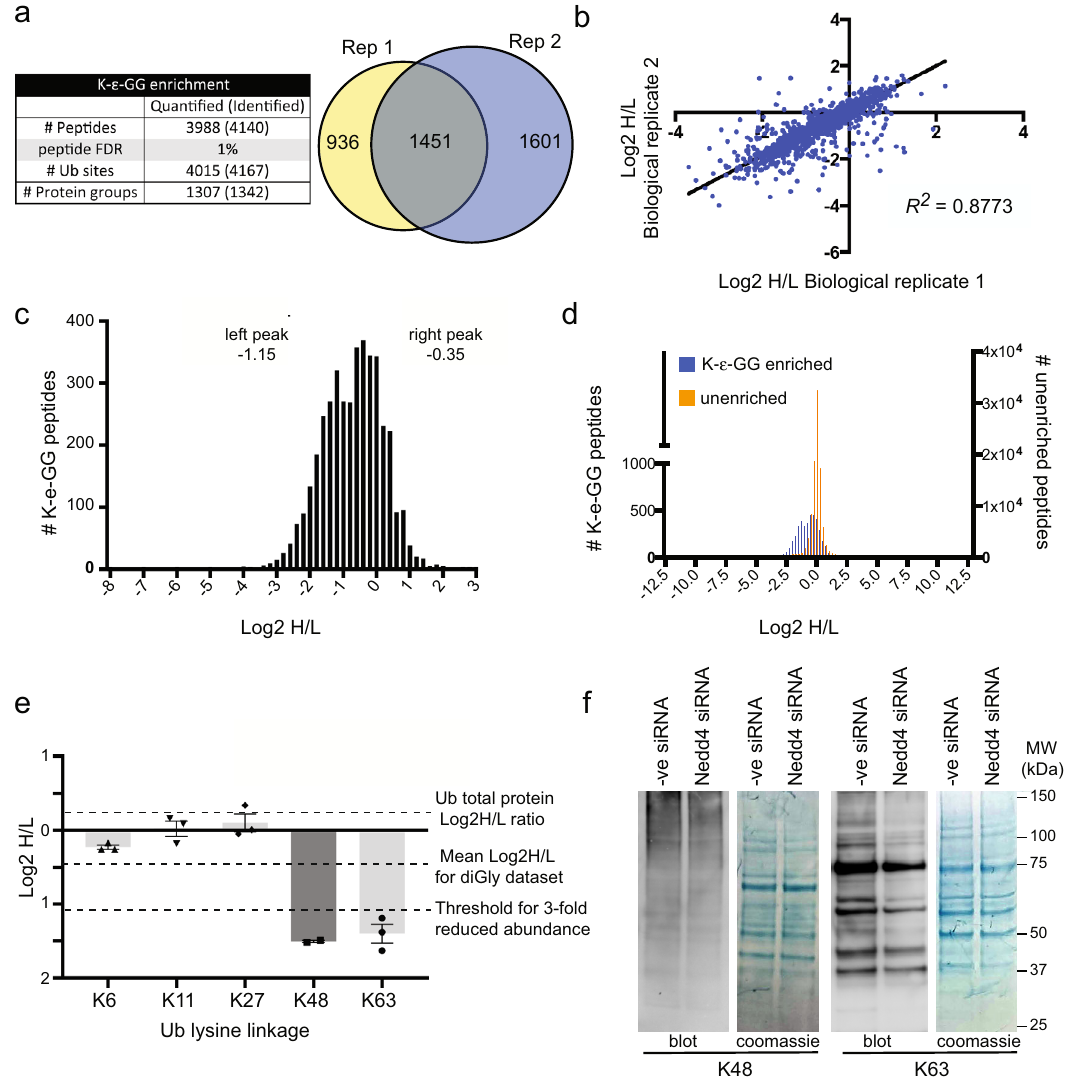
Fig. 2 Quantitative proteomic pro fi ling of NEDD4 regulated ubiquitination events. a Number of quanti fi ed ubiquitin (ub) remnant peptides and cognate protein groups (total number observed given in brackets). Venn diagram shows overlap of ubiquitin remnant peptides across 2 biological replicates (Rep). b Correlation of log2 H/L ratios between replicates ( R 2 = 0.8773). c The frequency distribution of log2 H/L ratios for ubiquitin remnant enriched (K- ε -GG) peptides has a large subset of ubiquitin remnant enriched peptides shifted left. The left peak has a mean of − 1.15 and right peak − 0.35. d Overlay of log2 H/L ratio distributions from ubiquitin remnant enriched (K- ε -GG) peptides (blue) and pre-enrichment peptides (orange) shows ubiquitin remnant peptide abundance is shifted left compared to the pre-enrichment peptide samples. e Log2 H/L ratios of ubiquitin remnant peptides derived from inter-ubiquitin isopeptide bonds. There is a speci fi c reduction in abundance of ubiquitin-derived peptides with K48 and K63 ubiquitin linkages following Nedd4 siRNA knockdown. Total ubiquitin abundance was not altered in the Nedd4 siRNA treated cells. Quantitation of the ubiquitin linkages was performed from 3 independent experiments. Data are presented as mean values + / − SEM. f Reduction of ubiquitin remnants for K48 and K63 linkage was con fi rmed by western blot using linkage-speci fi c antibodies. Note that equal amounts of lysate loaded as indicated in Coomassie brilliant blue-stained membrane. Blots are representative of 3 repeats. Uncropped images are provided as a Source data fi